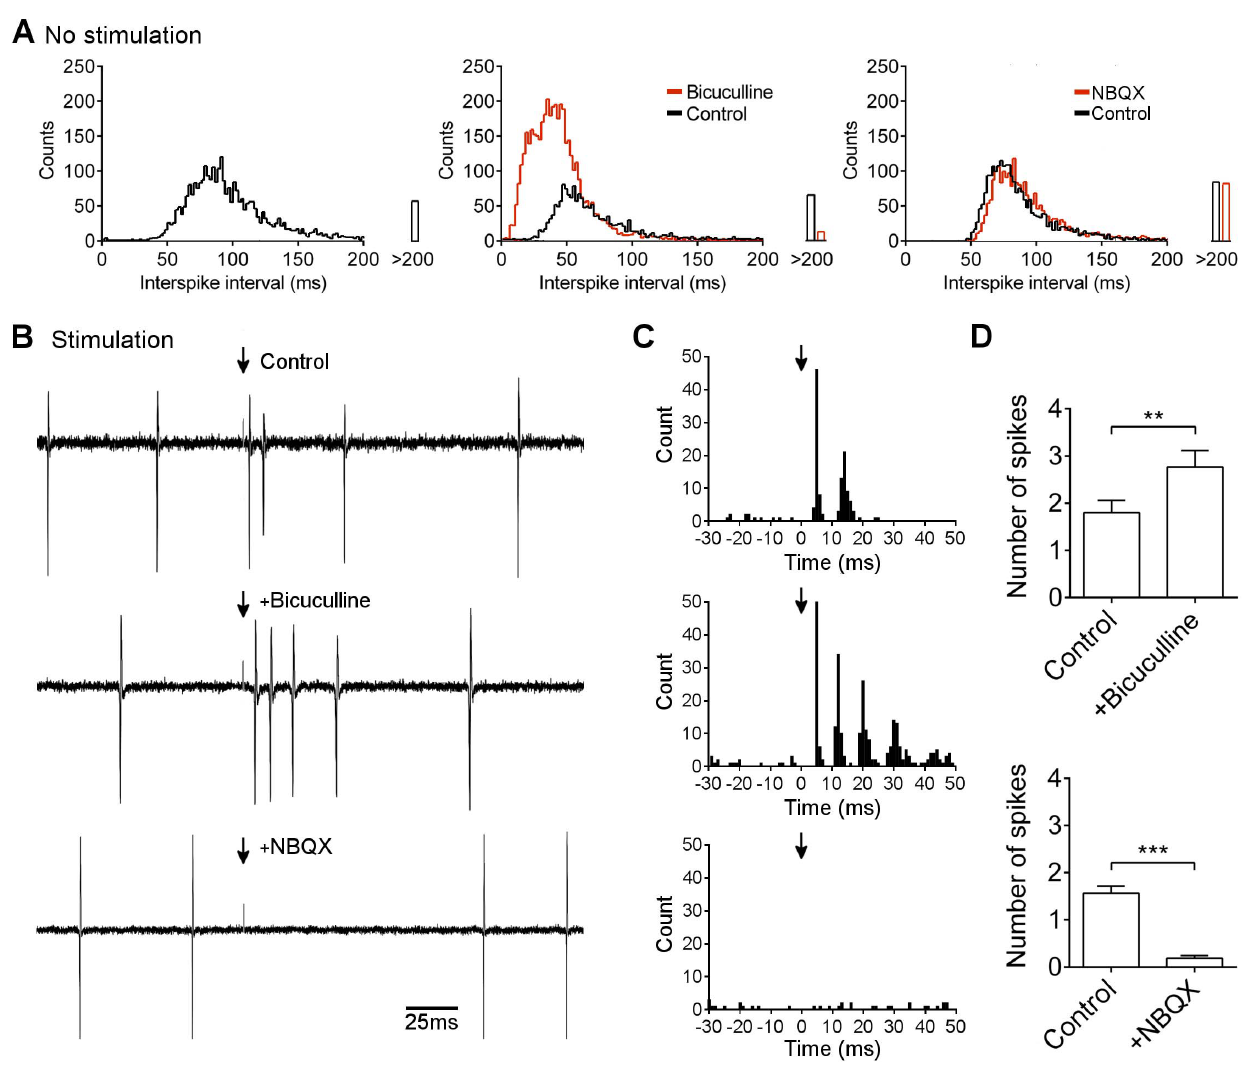
Figure 2. Effect of excitatory and inhibitory inputs on interspike interval. A) Distribution of spontaneous interspike intervals recorded over 10 min from a representative Purkinje neuron. Intervals greater than 200 ms in duration are pooled as a single population (bar graph to right of panel). First panel shows untreated cell, second panel shows a cell before (black line) and after (red line) 10 min incubation with 20 m M bicuculline, third panel shows a cell before (black line) and after (red line) 10 min incubation with 10 m M NBQX. B) Representative loose cell attached recordings from Purkinje neurons during stimulation of parallel fibre input in the molecular layer at 25 m A (arrow). Top trace shows untreated cell, middle trace shows cell incubated with 20 m M bicuculline for 10 min, lower trace shows cell incubated with 10 m M NBQX for 10 min. C) Post-stimulus histograms showing cumulative number of spikes from cells in panel B over 10 min of stimulation at 0.2 Hz. D) Aggregate data for mean 6 s.e.m. number of post-stimulus spikes within 50 ms of stimulation before and after addition of bicuculline (top panel) or NBQX (bottom panel). n=8 cells. **p=0.0061 and ***p=0.0003 (paired t test).